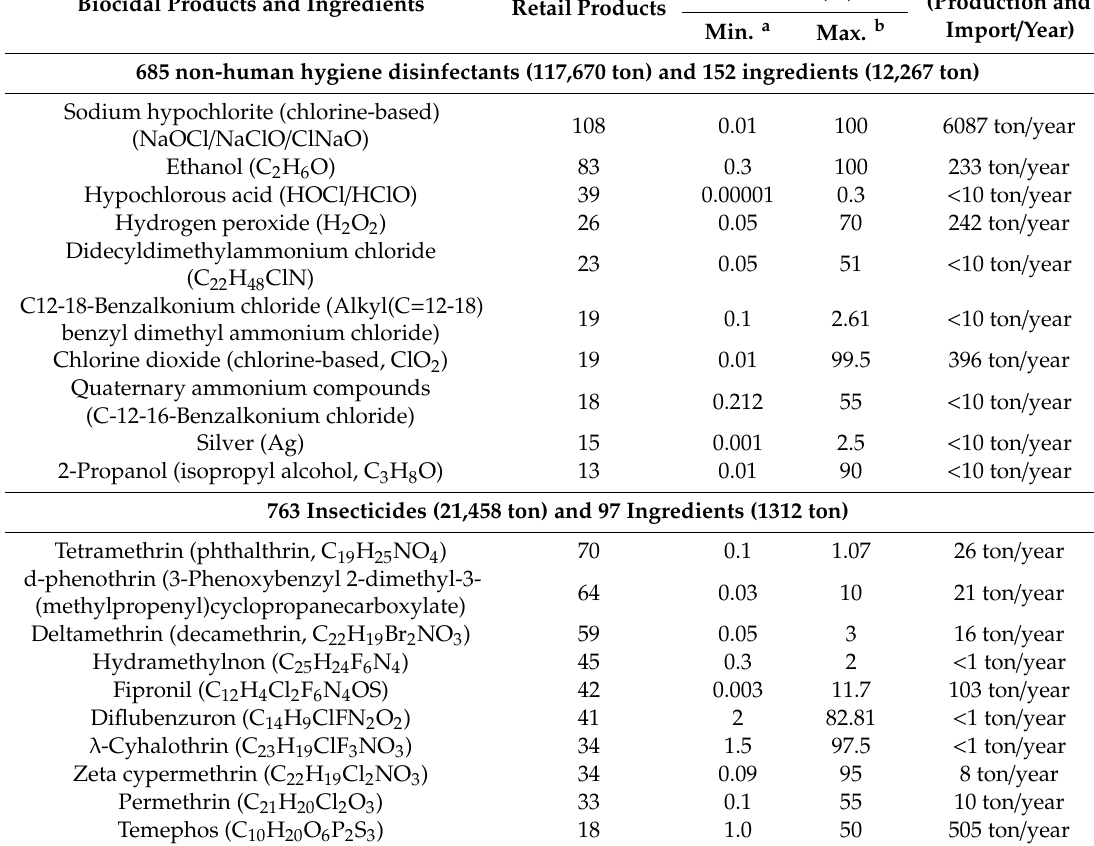
Table 5. Retail products and their active-ingredients characteristics based on distribution and sale. Biocidal Products and Ingredients